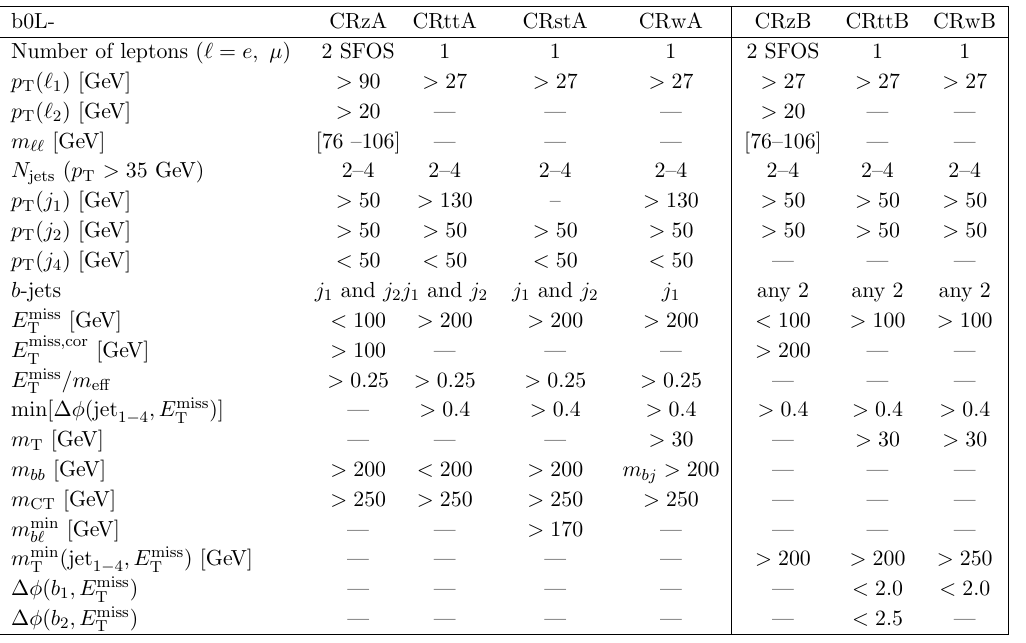
Table 3. Summary of the event selection in each control region corresponding to b0L-SRA and b0L-SRB. The term lepton is used in the table to refer to signal electrons and muons. Jets ( j 1 , j 2 , j 3 and j 4 ) and leptons ( ‘ 1 and ‘ 2 ) are labelled with an index corresponding to their decreasing order in p T .